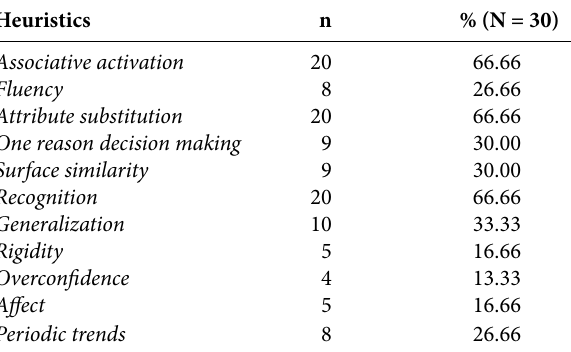
Table 3. Number and percentages of participants using relevant heuristic at least once (acidity strengths, HCl, H 2 S and HI) Heuristics